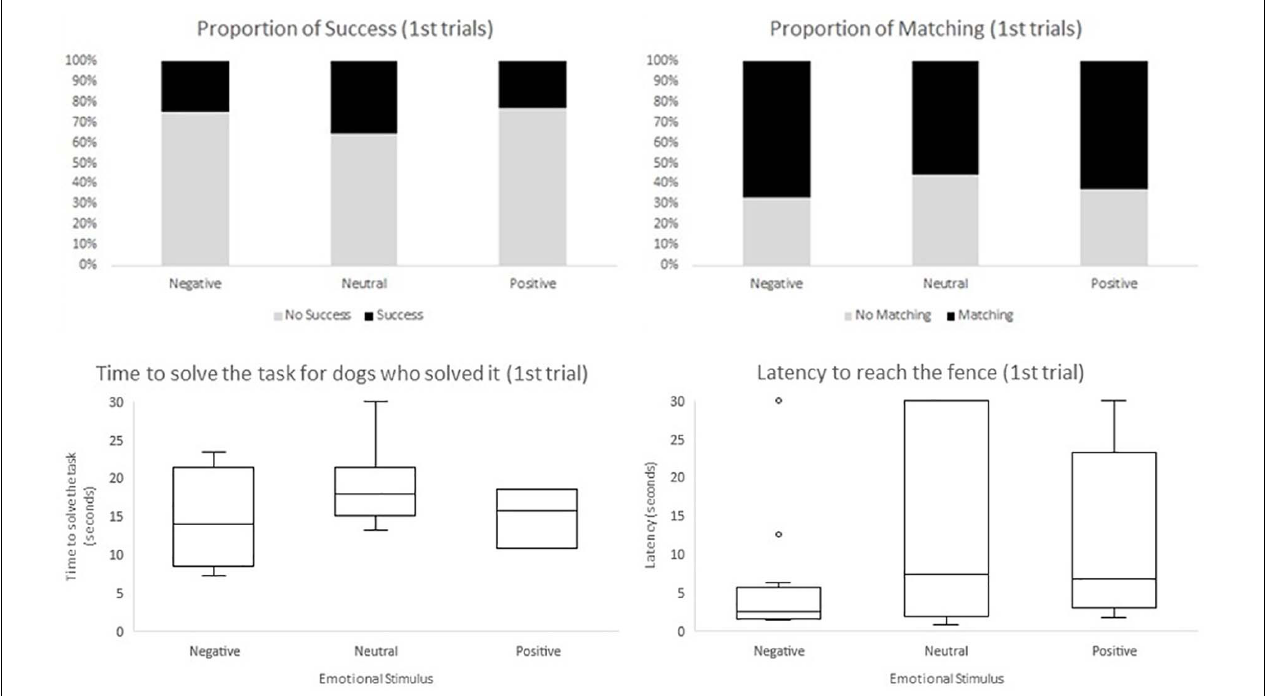
FIGURE 4 | Descriptives of the four dependent variables accounting the first trials, within each emotional group (negative, neutral, and positive). Shown as the proportion of success, the proportion of matching the side of demonstration and the box and whisker plot of time to solve the task and latency to reach the